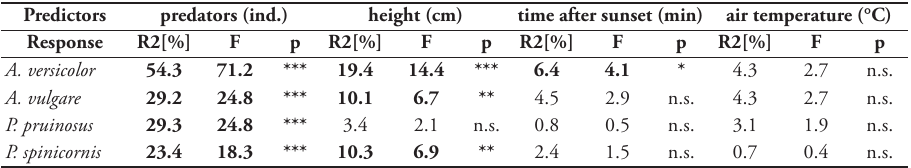
Table 1. Summary of fitted Generalised Additive Models for environmental variables predicting the numbers of observed terrestrial isopods on the wall during a 90-min observation in October 2019.